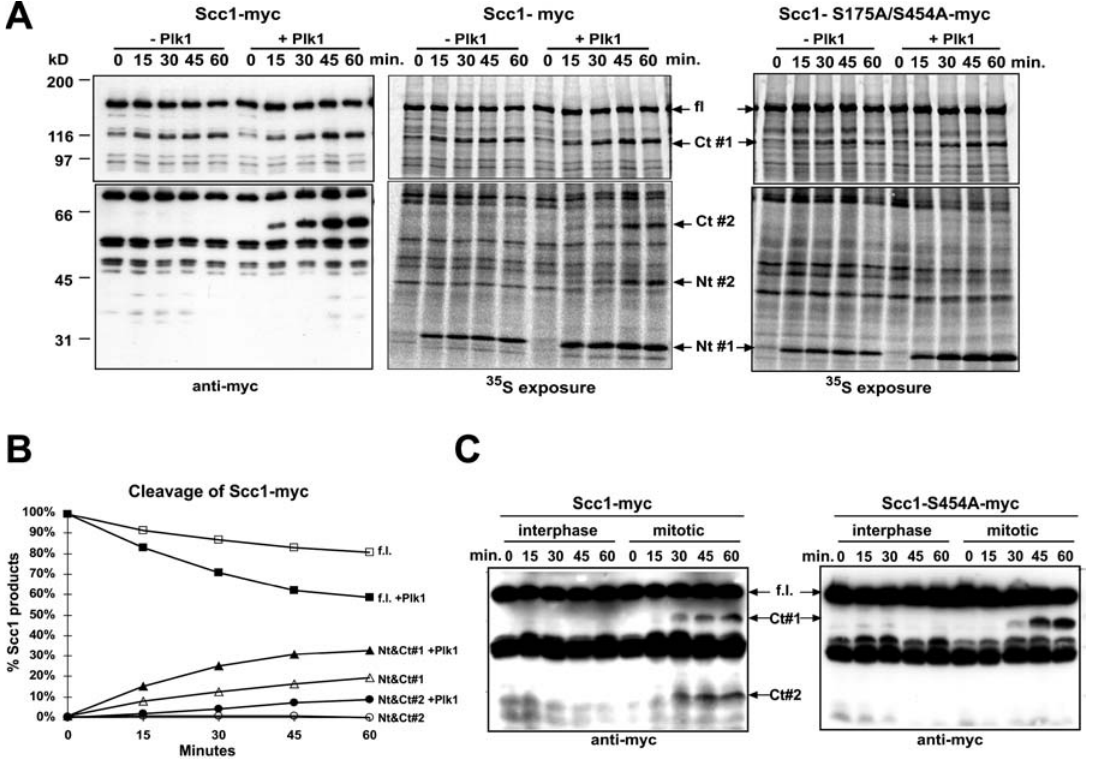
Figure 2. Plk1 Facilitates Cleavage of Human Scc1 by Separase In Vitro (A) Recombinant, 35 S-labeled, wild-type and mutant Scc1 (see Figure 1C) tagged with 9xmyc at the C terminus were incubated with human separase. Recombinant human GST-Plk1 was added to the reaction mixtures where indicated. Samples were withdrawn from the reactions at the indicated time points and analyzed by SDS-PAGE followed by immunoblotting (anti-myc) and Phosphorimager analysis ( 35 S exposure). Arrows indicate full length Scc1-myc (fl), C- and N-terminal fragments resulting from cleavage at Arg 172 (Ct #1, Nt #1, respectively), and C- and N- terminal fragments resulting from cleavage at Arg 450 (Ct #2, Nt #2, respectively). The lower parts of the membrane or gels were exposed longer than the upper parts. The enhancement of cleavage at Arg 172 by Plk1 can be seen particularly well by comparing the intensities of the N-terminal fragments (Nt #1). Note that in the autoradiographs a band can be seen (particularly clearly in the lanes representing the zero time points) that has almost the same electrophoretic mobility as cleavage product Ct #1. This band is distinct from Ct #1 because it migrates a slightly shorter distance and because it is also present in the absence of separase. This band was therefore not included in the quantification in (B). (B) Quantification of the abundance of Scc1-myc and the Scc1-myc cleavage fragments in the assay shown in the left autoradiograph of (A). For the quantification, autoradiographs of identical exposure were used. The sum of the intensities of full-length and all cleavage fragments was set to 100%. Signal intensities for N- and C-terminal fragments resulting from cleavage at the same site were summed. (C) Chromatin fractions were prepared from HeLa cells stably expressing either wild-type Scc1-myc or the mutant Scc1-S 454 A-myc, and were incubated in either interphase or mitotic Xenopus egg extract. Mitosis-specific cleavage of Scc1 was detected by immunoblotting with myc antibodies. DOI: